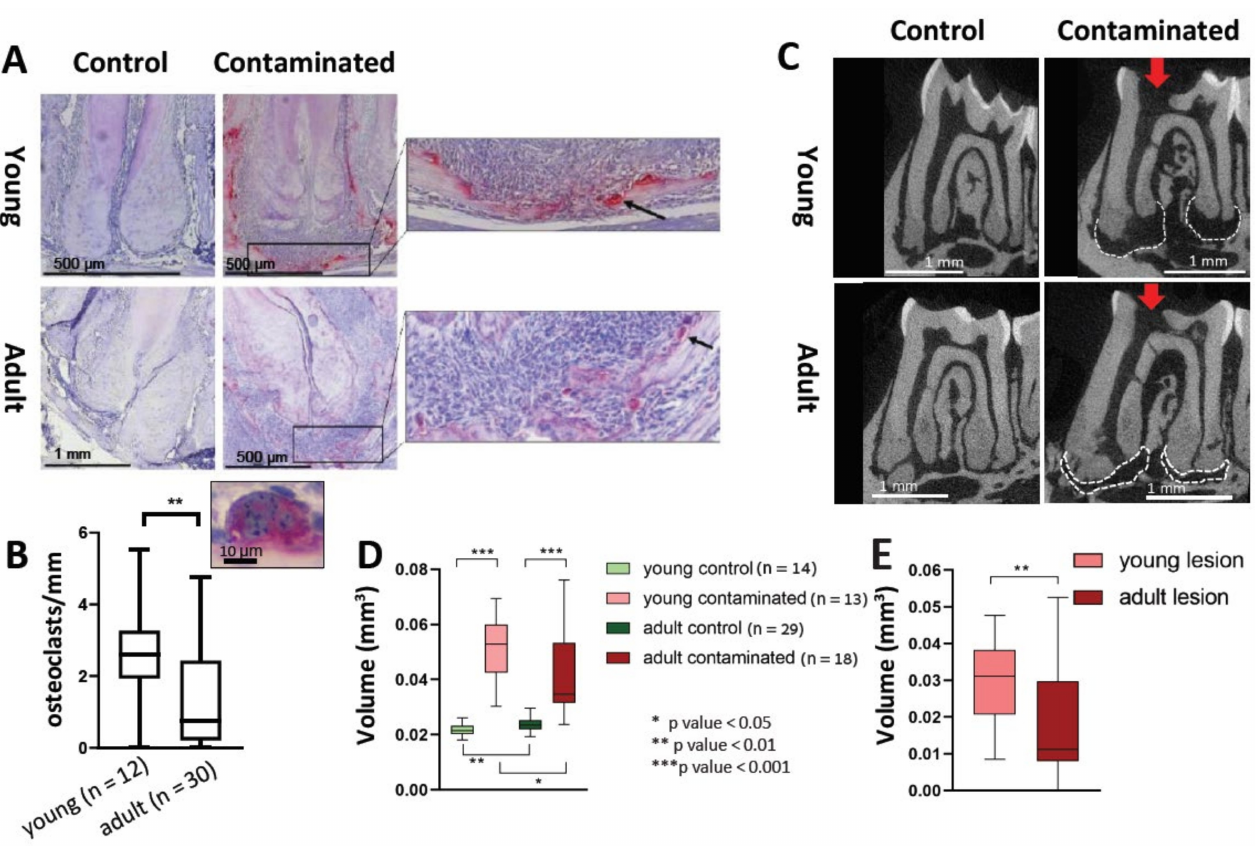
Figure 5. Bone resorption analysis. ( A , B ). Tartrate-resistant acid phosphatase (TRAP) analysis. The slides were stained for TRAP, and the number of TRAP positive multinucleated cells per mm of bone border length in the distal periapical region was quantified and compared for the different age groups. ( A ) Representative images. Representative images of control and contaminated teeth for both age groups. The arrows point to TRAP positive cells (stained red). ( B ) Quantification of osteoclasts. The number of TRAP-positive multinucleated cells ( ≥ 3 nuclei) per mm on the bone border was quantified and compared between the two age groups (only for the contaminated teeth, n = 12 (young), 30 (adult)). ( C – E ) micro-CT analysis. Samples were scanned by micro-CT in order to quantify the volume of the periapical lesion. ( C ) Representative images. Representative images of control and contaminated teeth for both age groups. Arrows point to the pulp exposure site. The white dashed line delineates the area of the lesion. ( D ) Volume of the radiolucent area. For all groups the periapical radiolucent volume was calculated. ( E ) Volume of the lesions. The volume of the periodontal ligament (PDL) area of the control teeth was subtracted from the radiolucent area of the contaminated teeth for each age group. The result is the volume of the bone resorption area